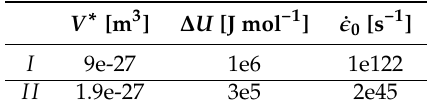
Table 3. Eyring parameters for γ